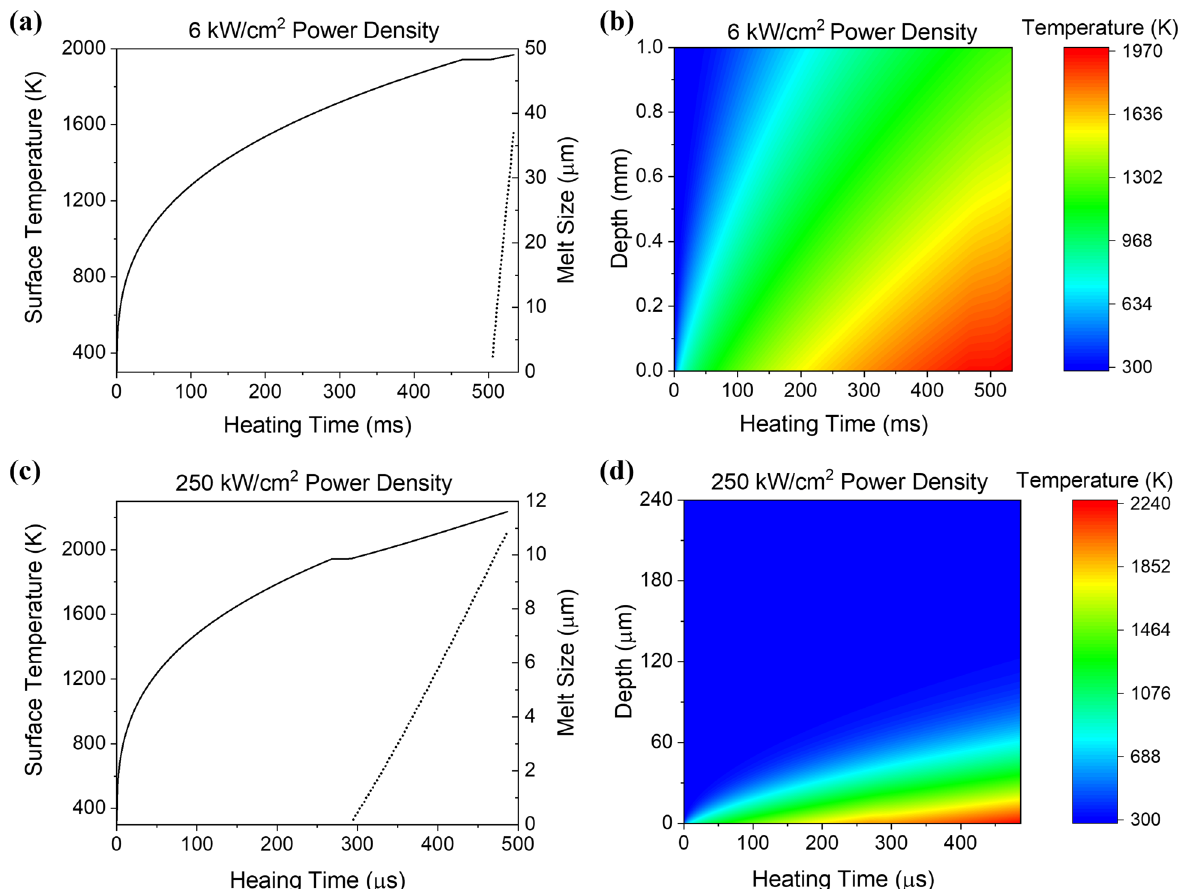
Figure 2. ( a ) Surface temperature (solid line) and melt size (dotted line) as a function of heating time for a 6 kW/cm 2 laser power density incident on Ti-6Al-4V. ( b ) Calculated temperature field as a function of heating time and depth for the 6 kW/cm 2 power density. ( c , d ) Results for a higher laser power density of 250 kW/cm 2